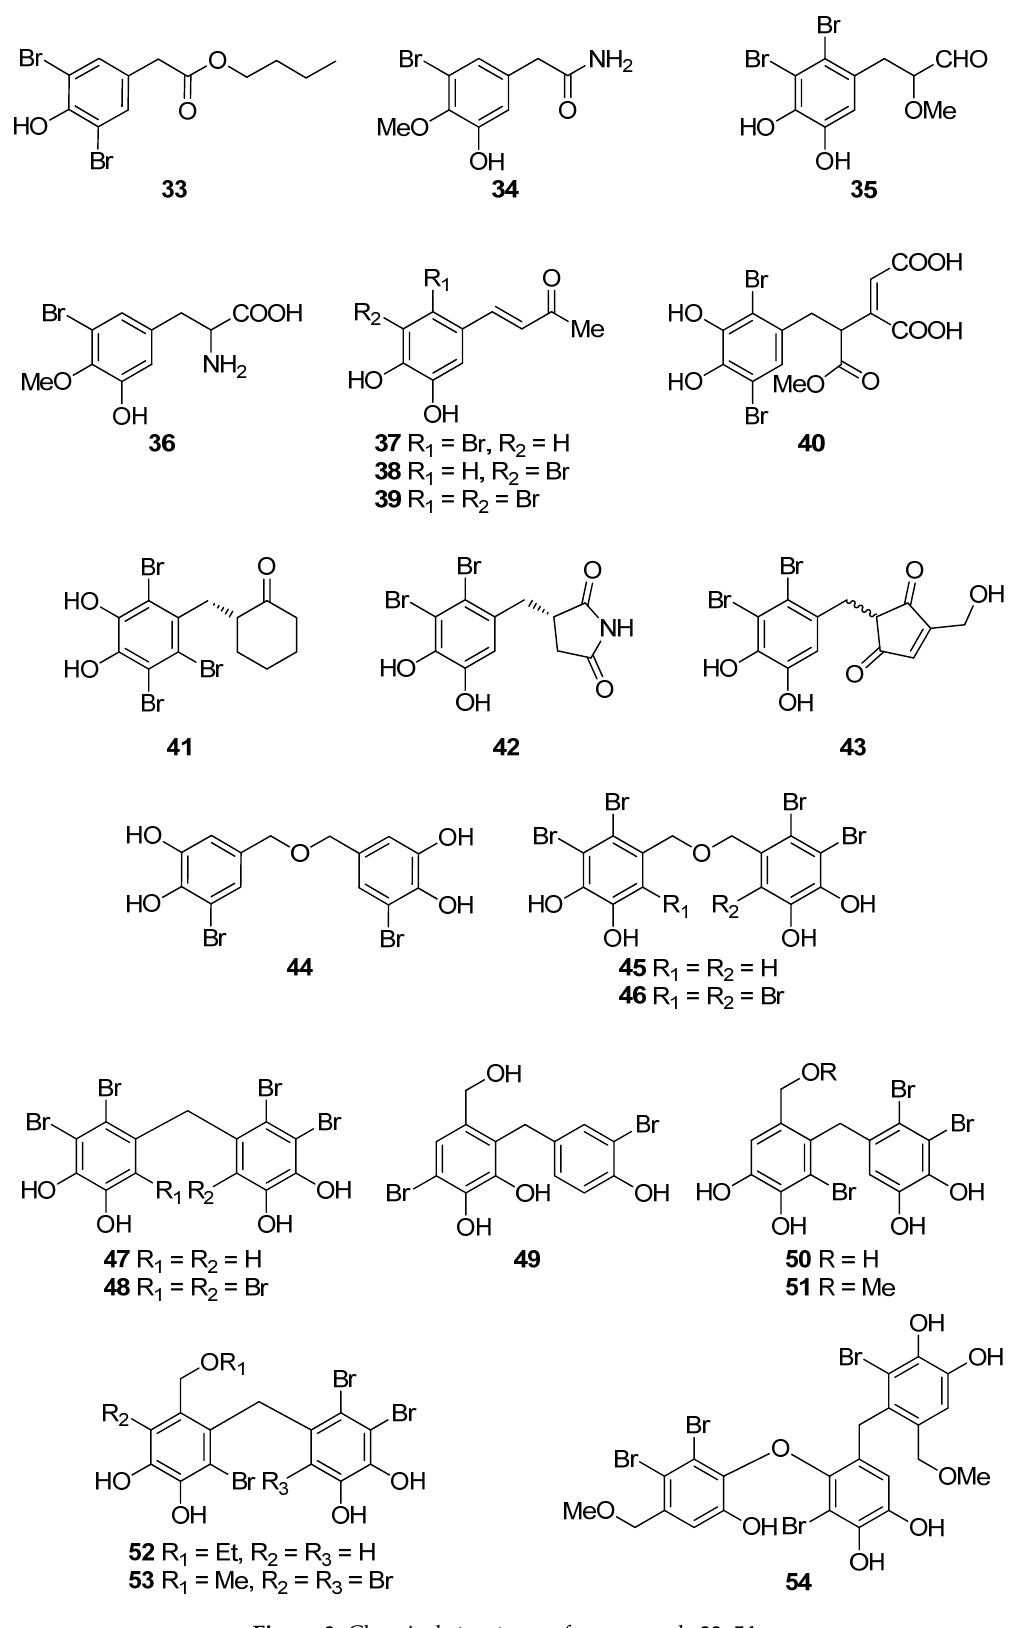
Figure 3. Chemical structures of compounds 33 – 54 .